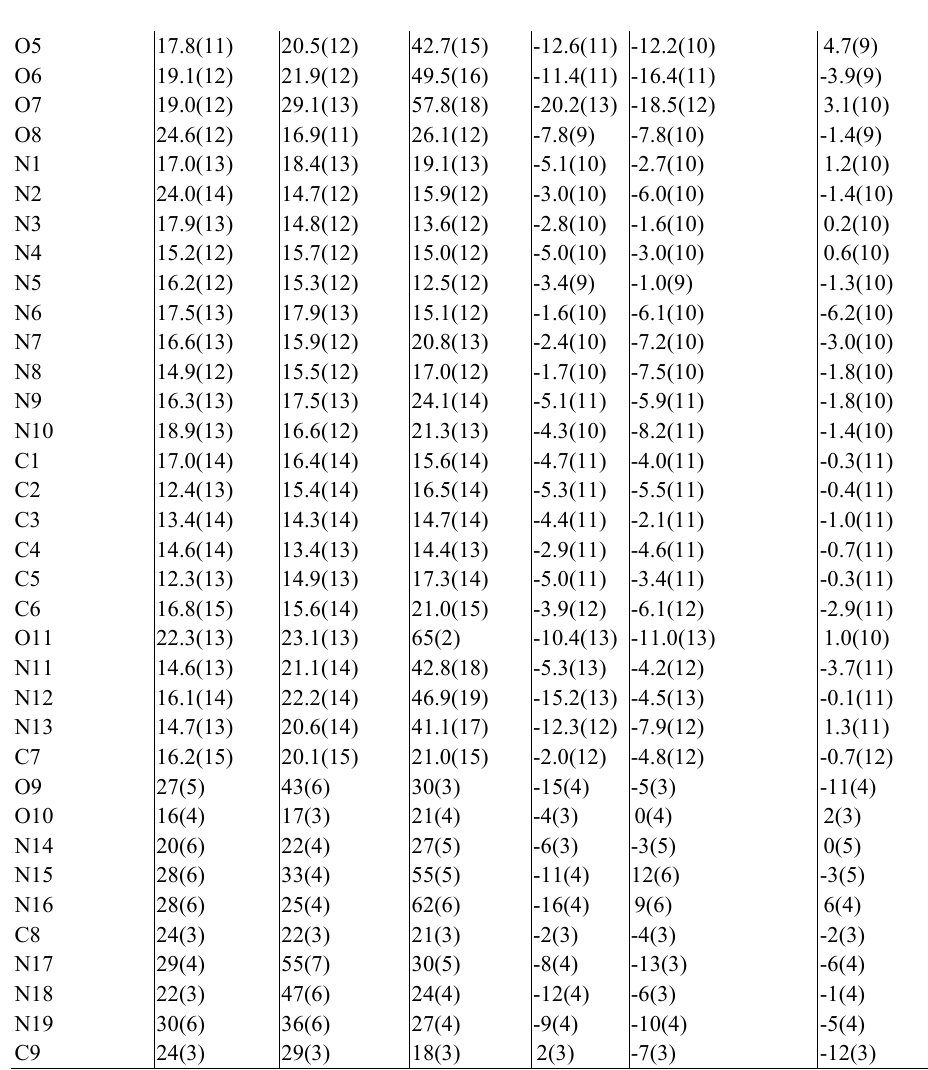
Table 4. Bond Lengths for 1